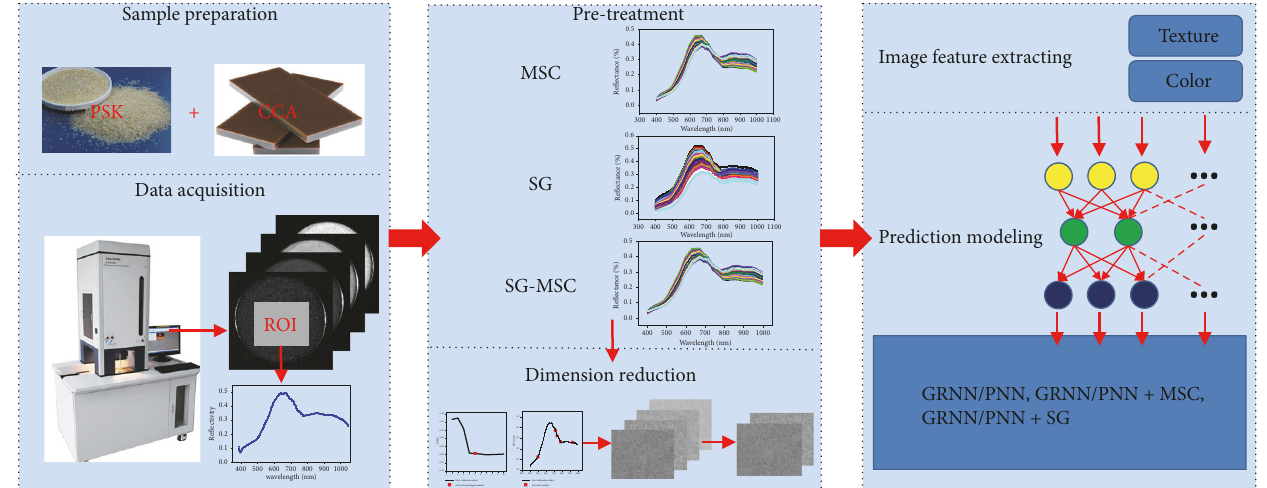
Figure 1: The key steps of measurement